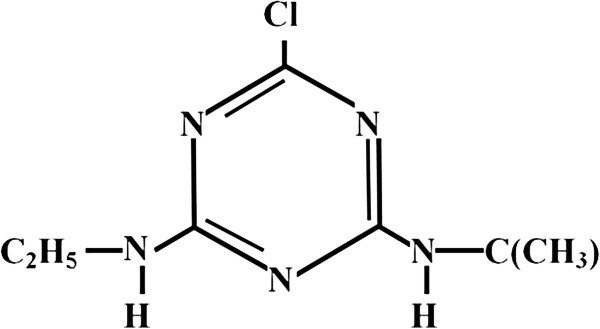
Chemical structure of the herbicide Atrazine[19-21].